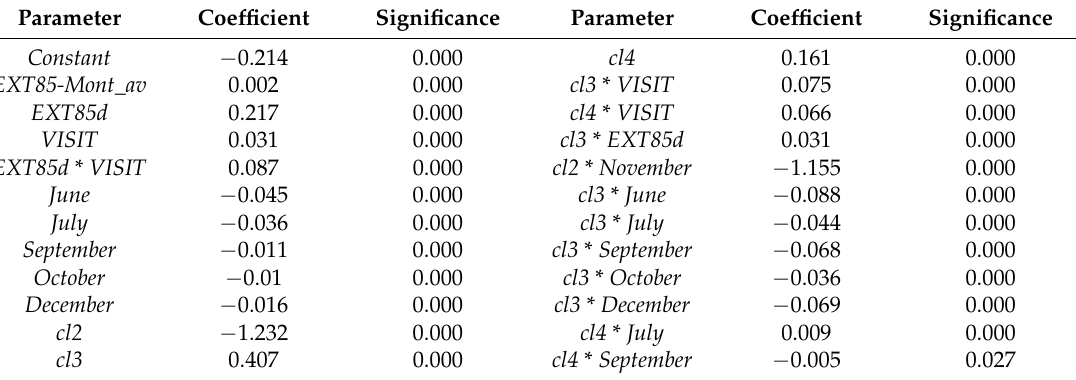
Table 4. Estimated coefficients of the independent variables (second multiple linear regression model). Parameter Coefficient